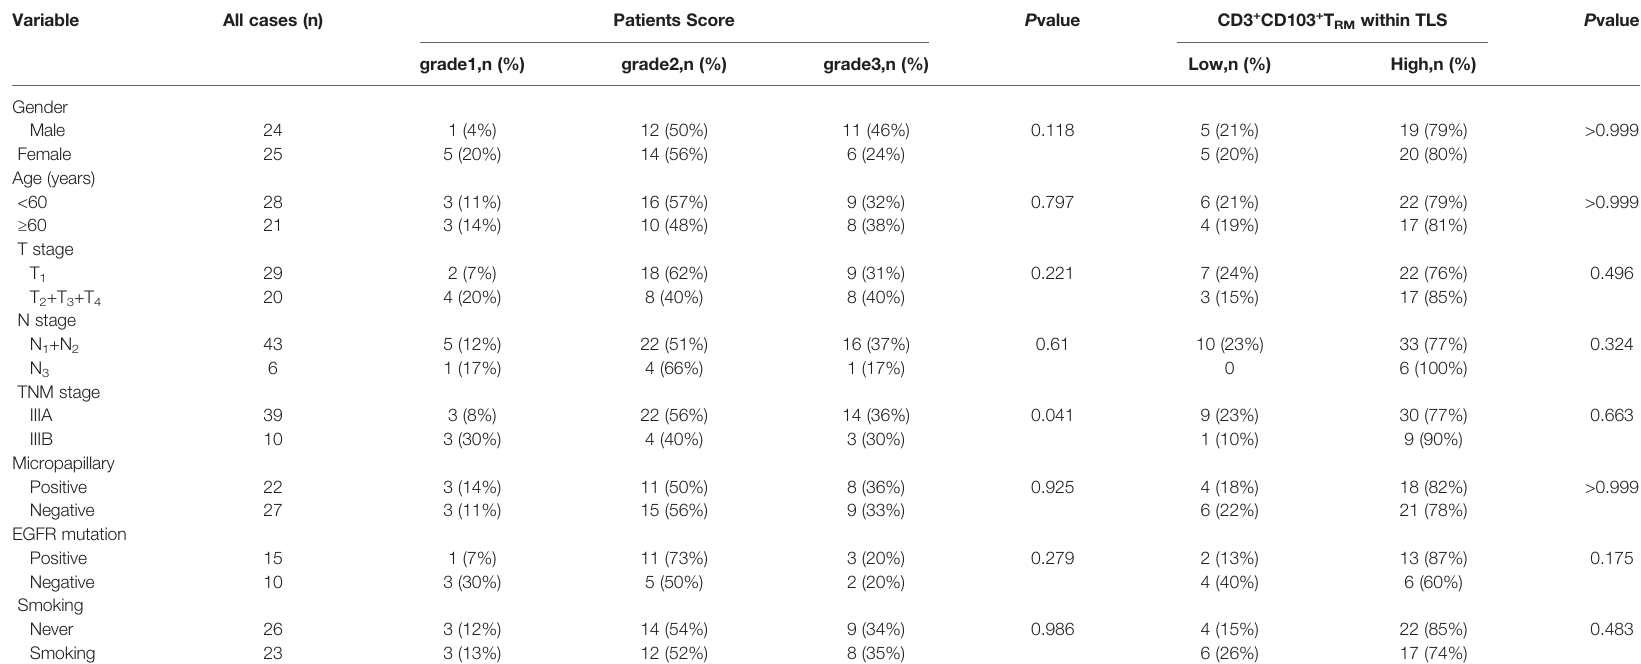
TABLE 3 | The relationship between patients score, CD3 + CD103 + T RM within TLS and various clinical parameters in patients with stage III LUAD (n=49). Variable